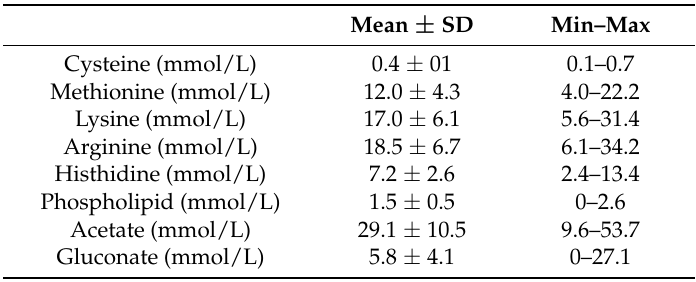
Table 3. Mean ± SD and minimum-maximum (min–max) values of the concentration of substances in the compounded parenteral mixtures evaluated in this study ( n = 50) that affect the renal acid load after their